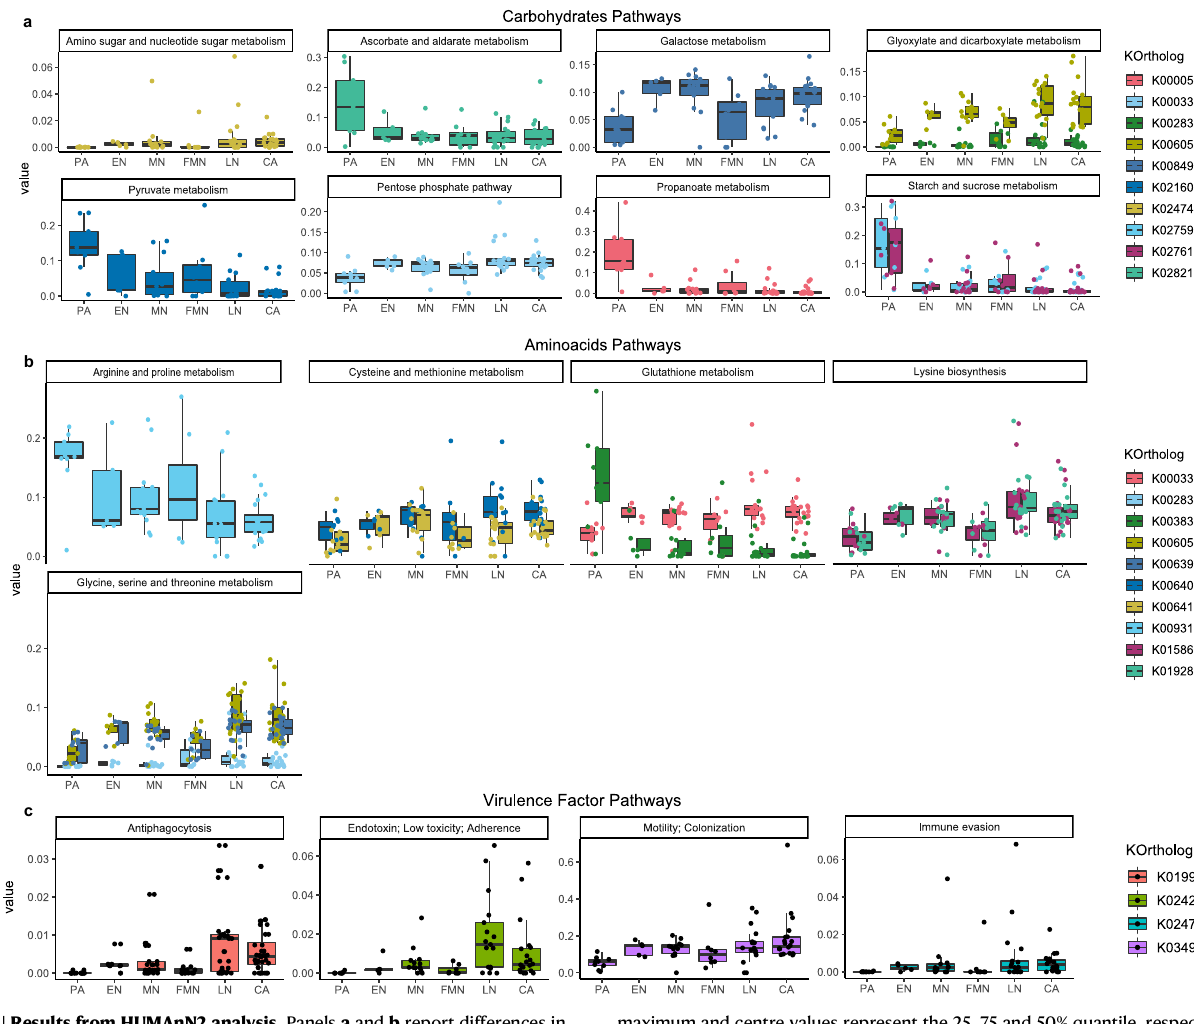
maximum and centre values represent the 25, 75 and 50% quantile, respectively; median is represented by 50% quantile; upper and lower whiskers are the max- imum/minimumvaluesofdatawhicharewithinthe1.5interquartilerangeover75th orunder25thpercentile,respectively.SourcedataareprovidedasSourcedata fi